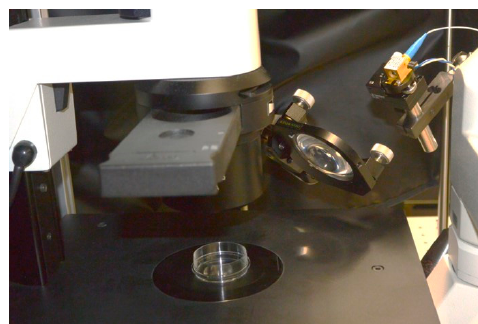
Figure 3. Uni-Travelling-Carrier Photodiode (UTC-PD) optical system on the inverted microscope. 2.2. Cells Used for the THz Wave Exposure